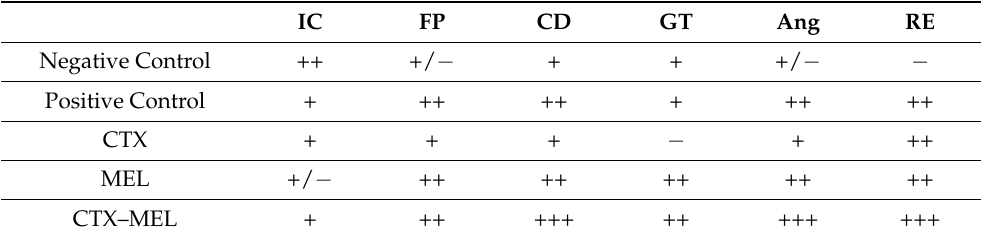
Table 2. Histological evaluation of wound healing on day 14 in animals part of negative and positive control groups and in animals receiving the topical application of CFX, MEL, or CFX-MEL